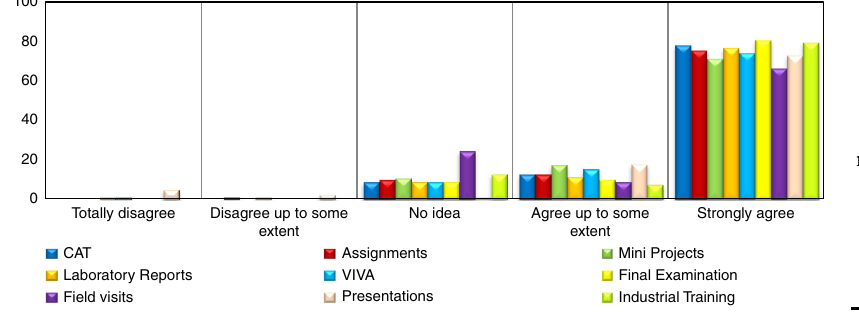
Figure 7. Psychological barriers rated as insignificant for on- time completion of the degree programmes